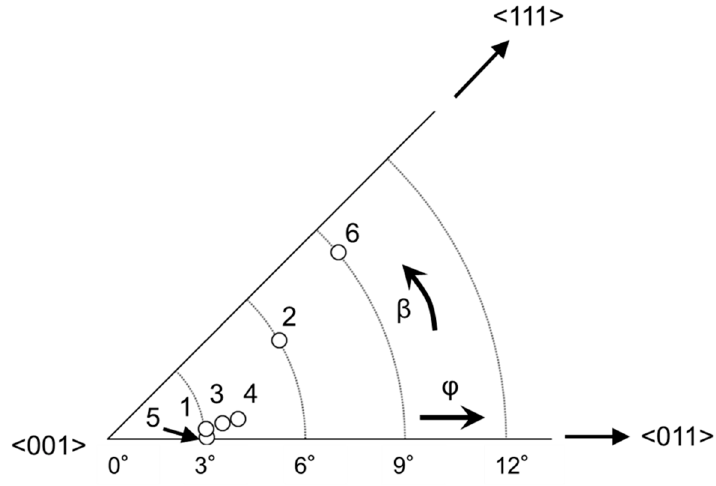
Figure 1. The crystal orientations of single-crystal rods for the tensile tests. Numbers in the figure denote specimens which appear in Table 2.